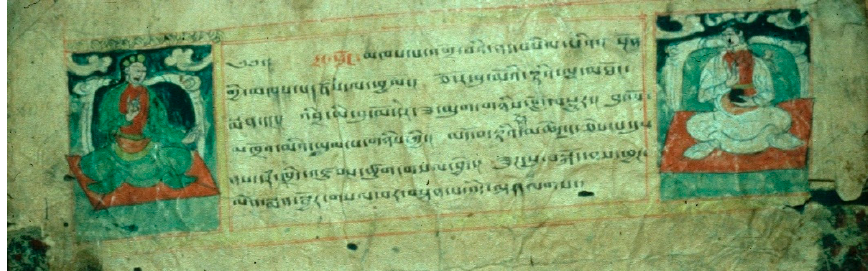
Figure 1. Manuscript in the possession of Pel Gonpo (dPal mgon po), prince of Jharkot (Mustang,